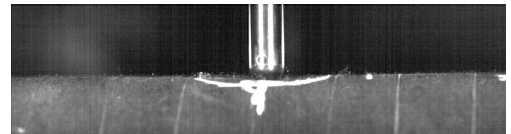
Fig. 20. A tup that is connected to the drop carriage by an aluminum extension strikes the